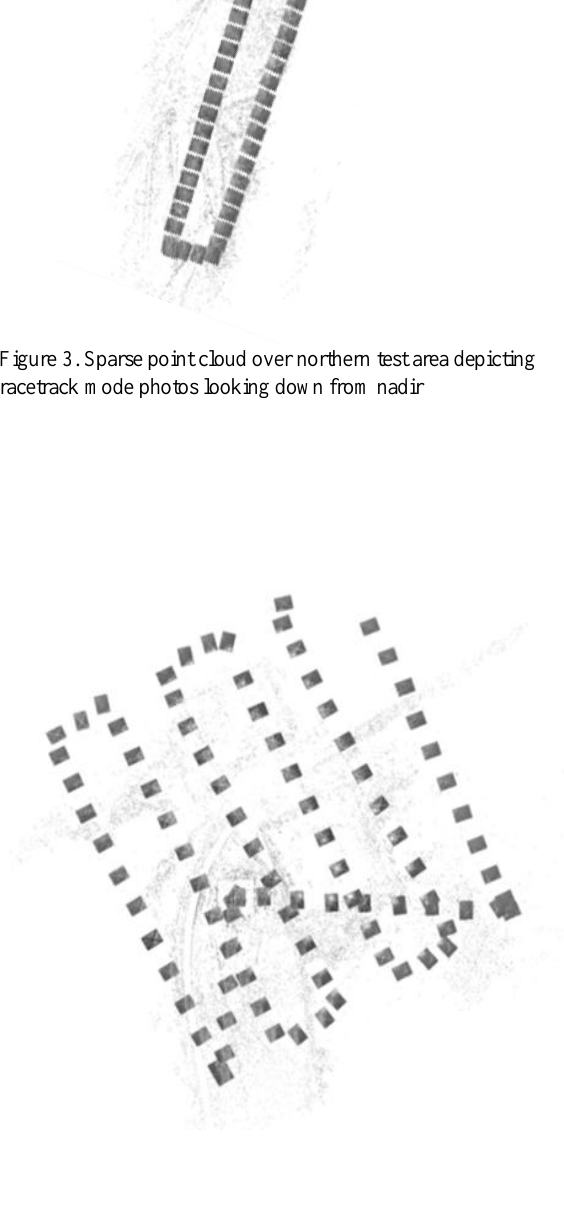
Figure 4. Sparse point cloud over north-most test area depicting lawnmower mode photos looking down from